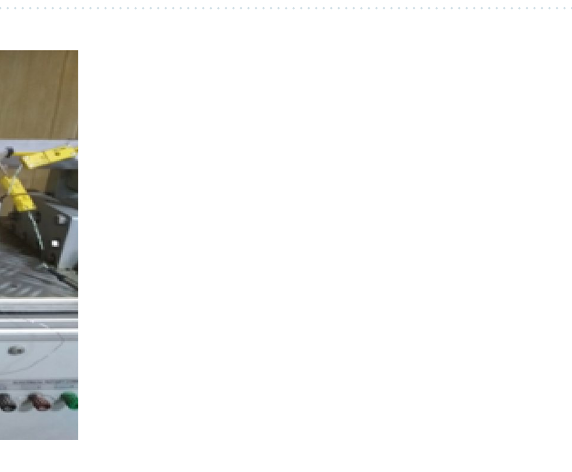
Figure 4. Samples installation inside the elbow.